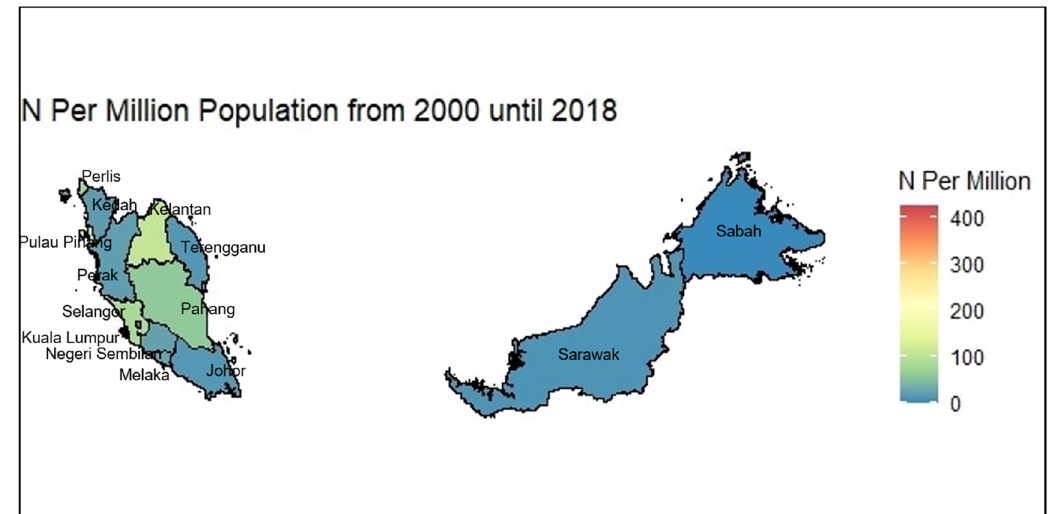
Figure 4. Hotspot analysis of the scientific productivity values by states in Malaysia.